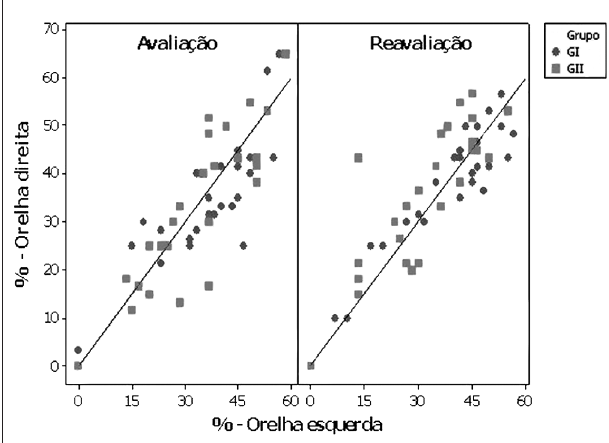
Figura 1. Diagramas de dispersão do GIN_% de acordo com a variável orelha e avaliação - GIN_%- porcentagem de reconhecimento de gap do teste GIN.